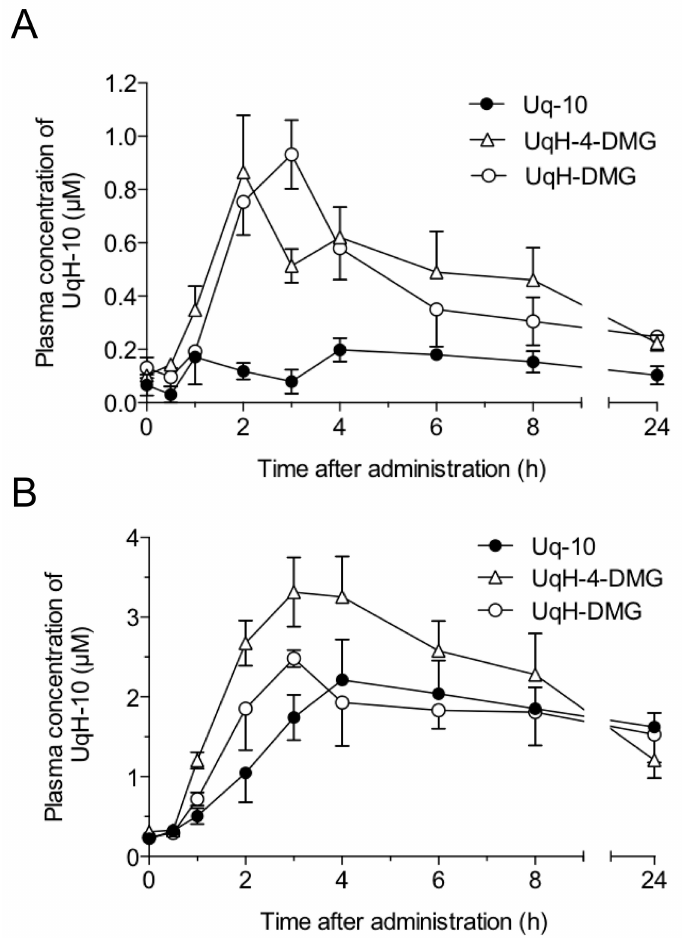
Figure 4. Plasma concentration of UqH-10 after administration of UqH-derivatives or Uq-10 in fasted and postprandial rats. ( A ) Plasma concentration of UqH-10 after administration of 40.5 mmol / kg weight of UqH-DMG, UqH-4-DMG or Uq-10 in fasted rats (UqH-DMG, n = 6; UqH-4-DMG, n = 5; Uq-10, n = 4); ( B ) plasma concentration of UqH-10 after administration of 40.5 mmol / kg weight of Table 2. Pharmacokinetic parameters for UqH-10 after oral administration of UqH-DMG, UqH-4-DMG, or Uq-10 in fasted and postprandial rats.